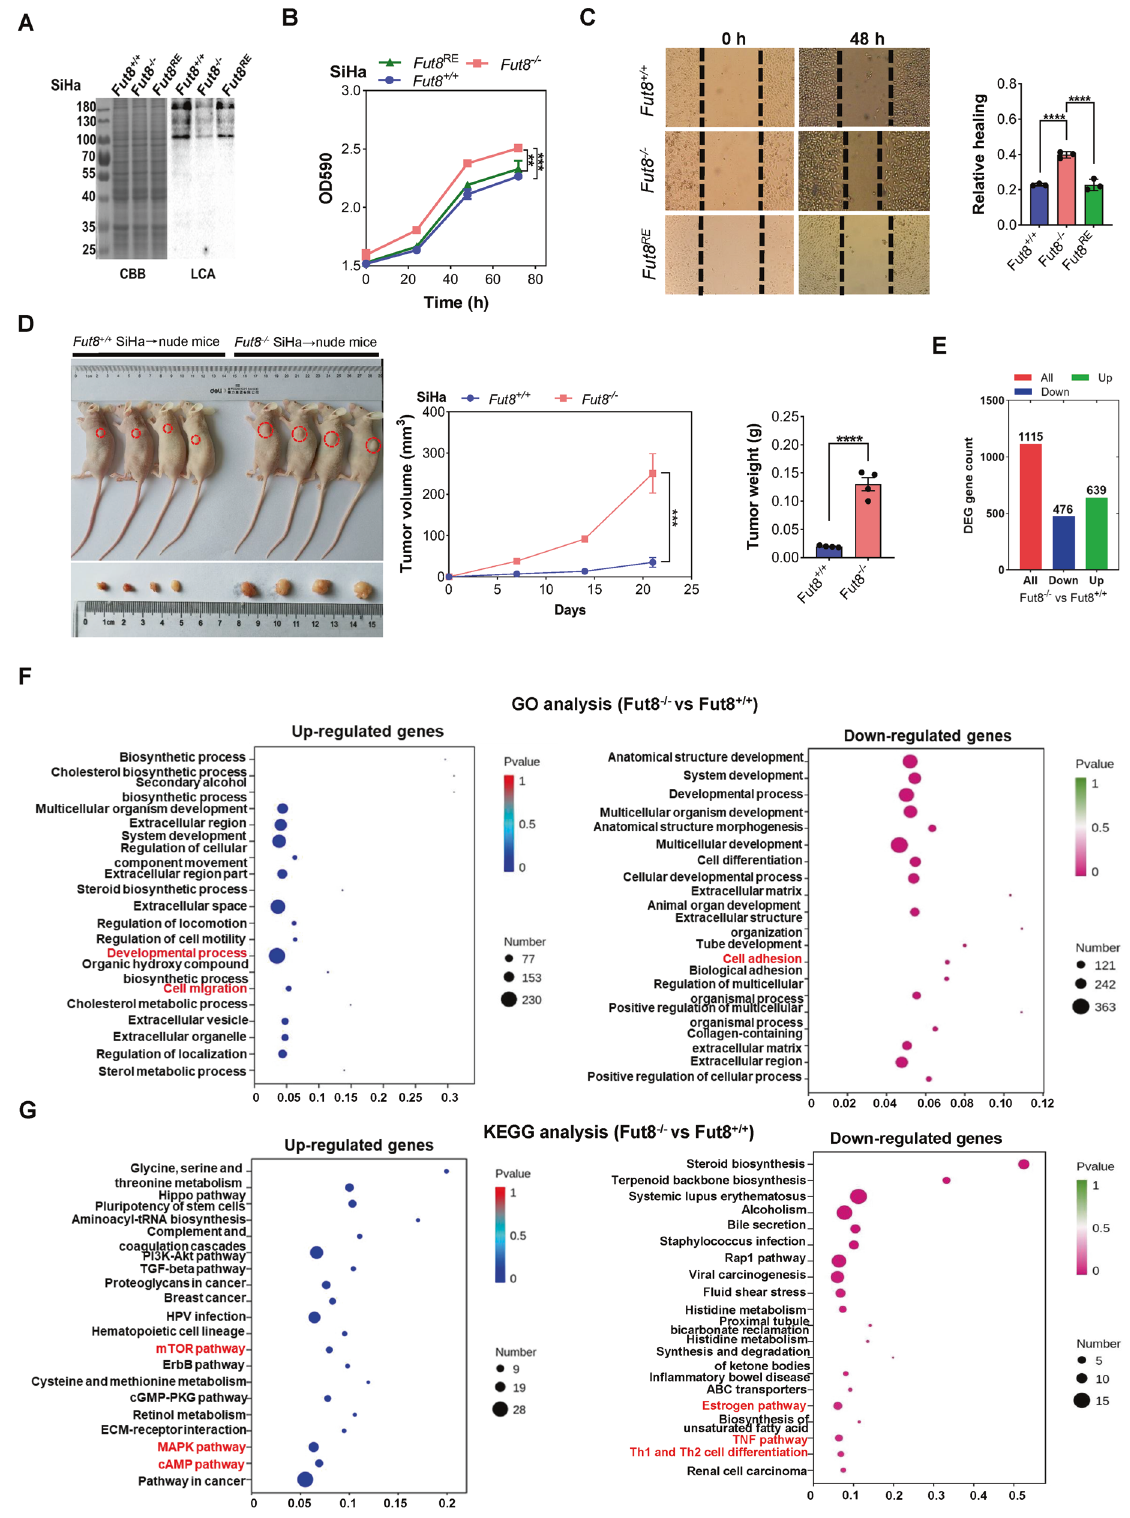
Fig. 2 The effect of de-core fucosylation on the occurrence and development of cervical cancer. A LCA blotting was used to verify Fut8 gene knockout in SiHa cells. B An MTT assay was used to evaluate the effect of Fut8 gene knockout on the proliferation of SiHa cells. C A scratch assay was used to evaluate the effect of Fut8 gene knockout on the migration of SiHa cells. D Fut8 + / + and Fut8 − / − SiHa cells were injected into nude mice to detect tumor formation in vivo. *** p < 0.001, **** p < 0.0001. E Histogram of differentially expressed genes in Fut8 − / − SiHa cells compared to Fut8 + / + SiHa cells. F Bubble plots of GO enrichment analysis of differentially expressed genes in Fut8 − / − SiHa cells compared to Fut8 + / + SiHa cells. G Bubble plots of KEGG enrichment analysis of differentially expressed genes in Fut8 − / − SiHa cells compared to Fut8 + / + SiHa cells.